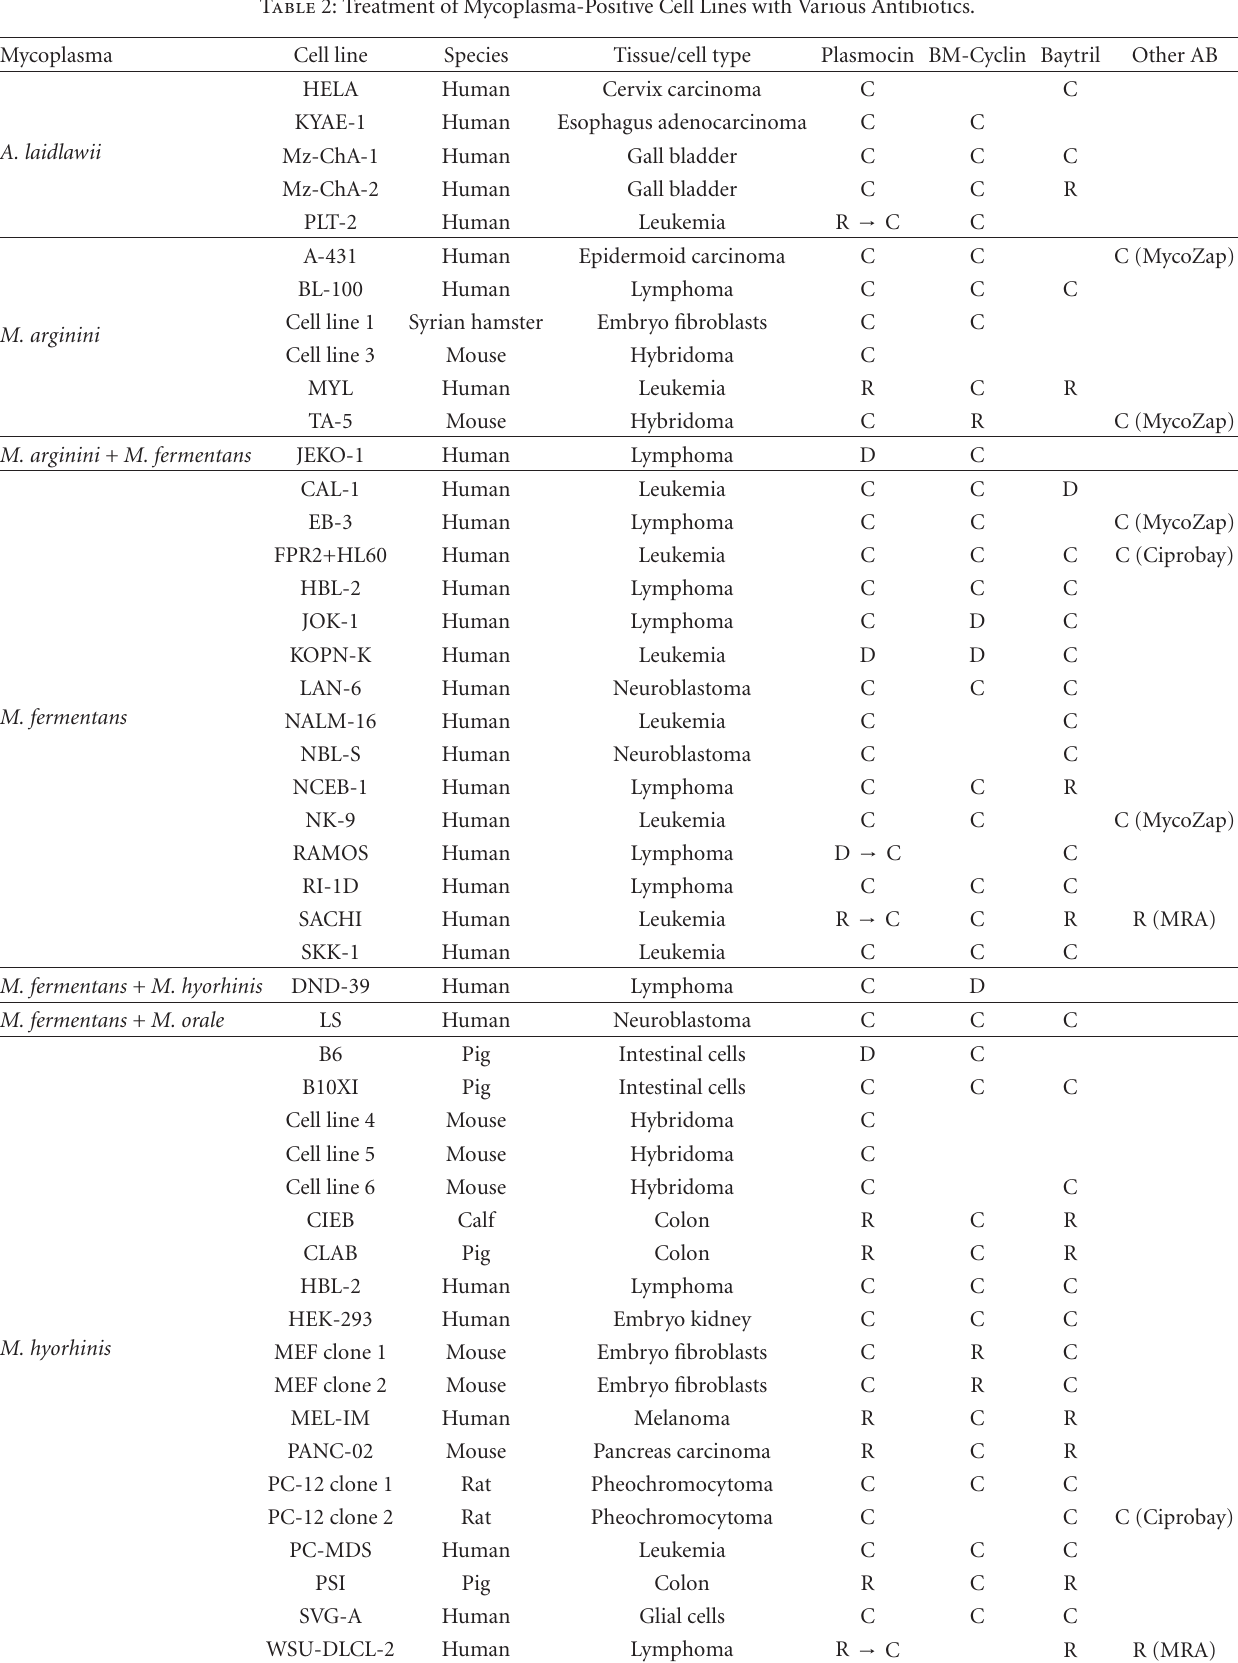
Table 2: Treatment of Mycoplasma-Positive Cell Lines with Various